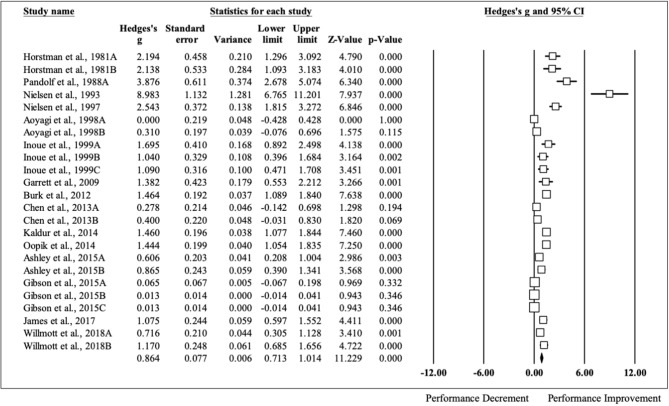
Time to exhaustion forest plot. Data are presented as Hedge's g and 95% confidence intervals.